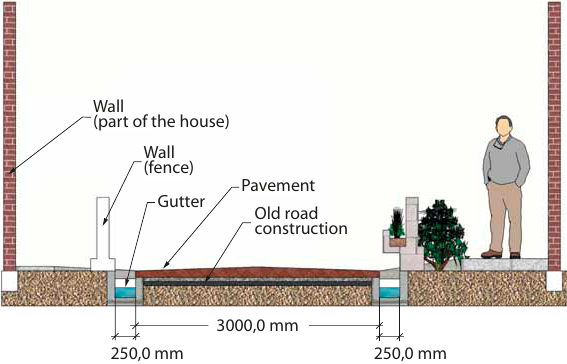
fig. 4. Section of alley in rT 4 Kampung Karangrejo Sawah (created by the author)